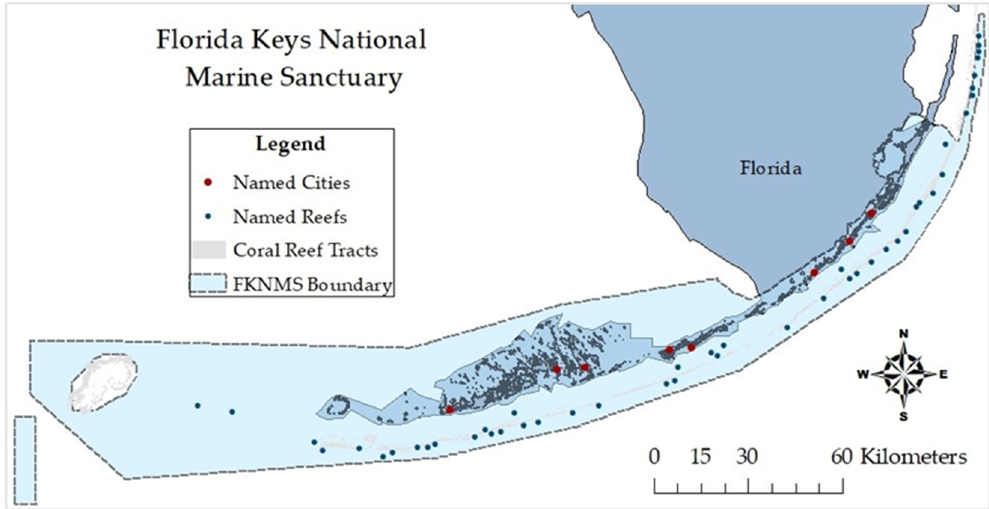
Figure 1. Florida Keys National Marine Sanctuary.